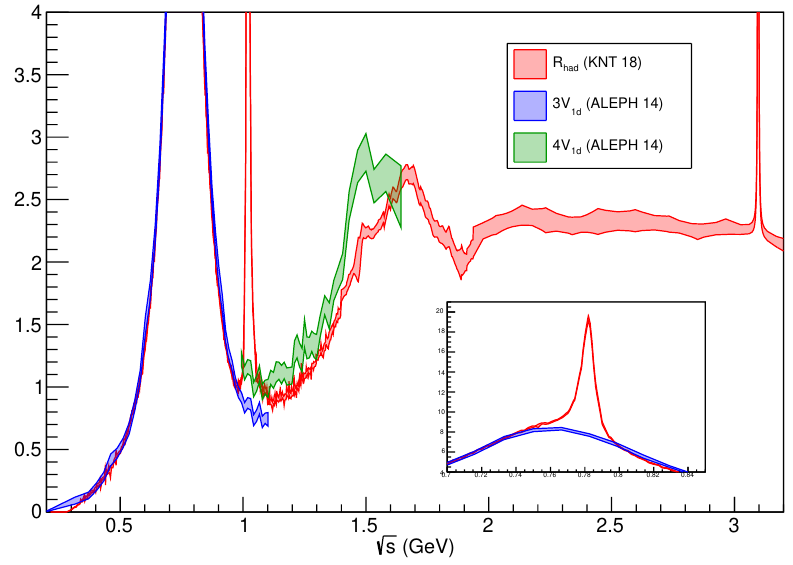
Figure 3 . The hadronic R-ratio [78] and spectral function from hadronic (cid:28) decay [90]. Under isospin considerations, 3 V is to be compared with the isovector contribution to R 1 d (cid:26) resonance) with the discrepancy due to the ! shown in the sub(cid:12)gure. Flavour SU(3) symmetry predicts R = 4 V . For further details see section had 1 d